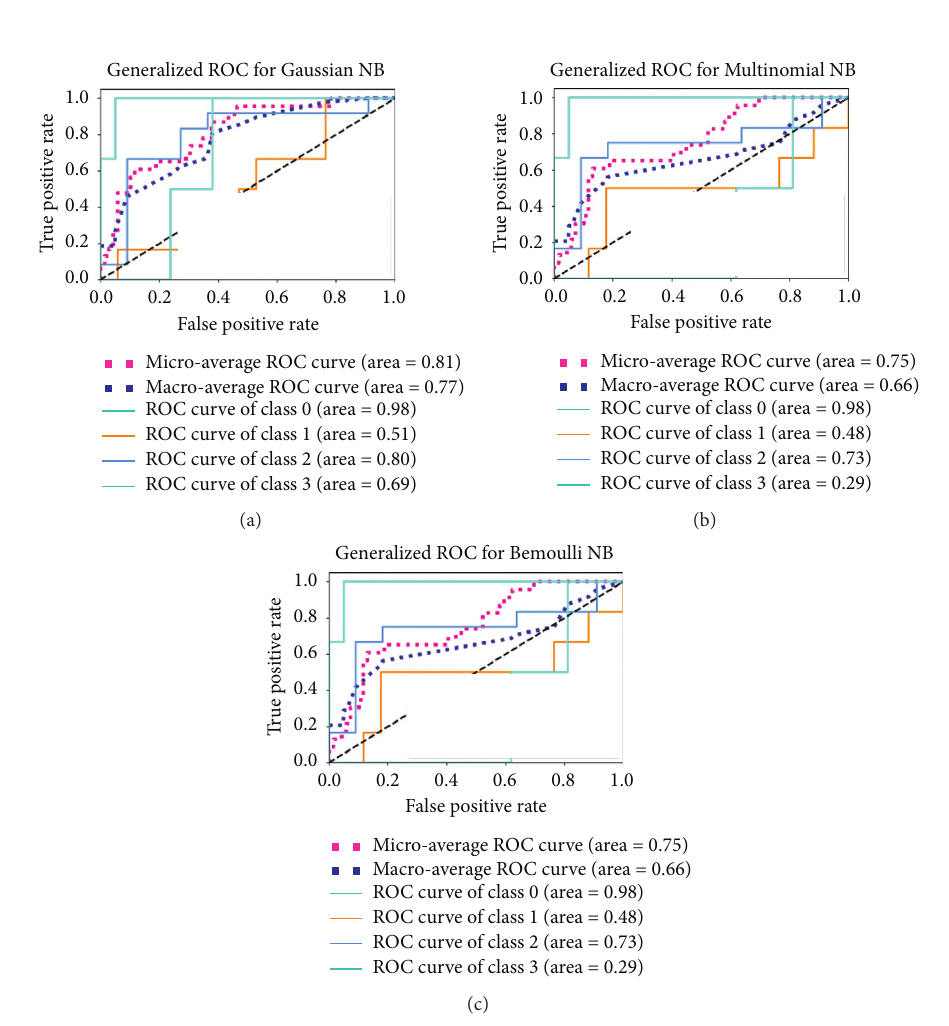
Figure 3: ROC curves and corresponding AUCs for three Bayesian